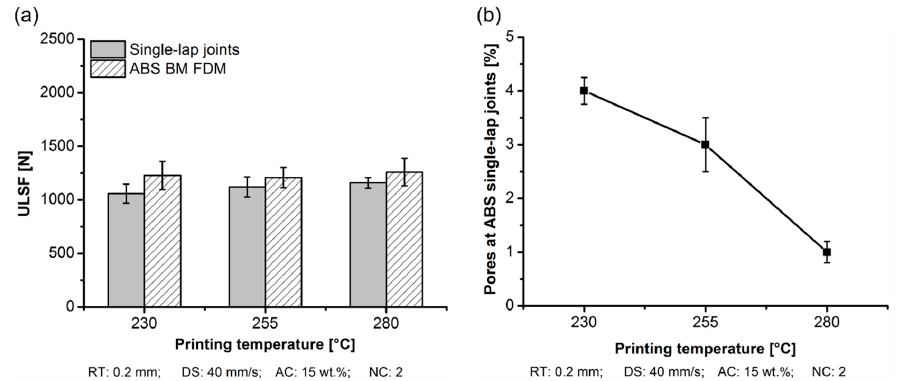
Figure 9. Influence of the printing temperature on the aluminum 2024-T3/ABS hybrid (single-lap joints) and ABS BM FDM ( a ) ULSF and ( b ) pores formation at the ABS part; (condition one, PT: 230 °C; condition two, PT: 255 °C; condition three, PT: 280 °C; the following parameters RT: 0.2 mm, DS: 40 mm/s, AC: 15 wt.%, and NC: 2 were fixed for the conditions investigated).